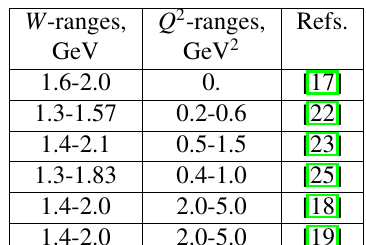
Table 1. The kinematic areas covered in the CLAS measurements of exclusive π + π − p photo- and electroproduction. Refs [17–19, 22, 23, 25] include nine di ff erential and fully integrated cross sections. Ref [19] additionally includes the